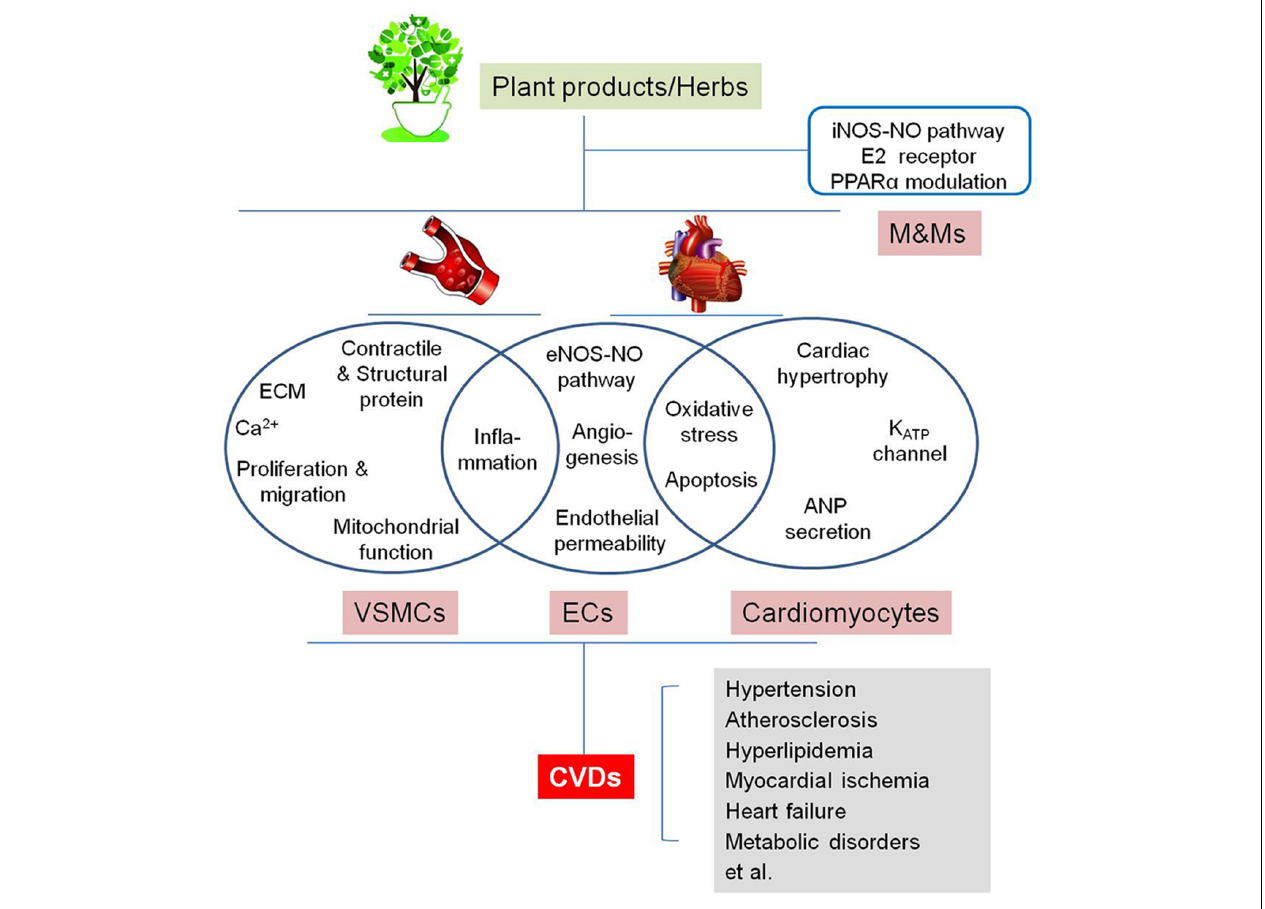
FIGURE 1 | A schematic diagraph indicating the targets on which plant products/herbs act during the pathogenesis of CVDs. Plant products/herbs demonstrate protective effect in CVDs by attenuating damage in cardiomyocytes, endothelial cells (ECs), vascular smooth muscle cells (VSMCs) and macrophages/monocytes (M&Ms). In VSMCs, plant products/herbs show the beneficial effect by inhibiting expression or activity of contractile and structural proteins, modulating expression of ECM proteins/glycoproteins, regulating calcium levels, attenuating proliferation and migrations, alleviating inflammation, and improving mitochondrial function. In ECs, plant products/herbs show the beneficial effect by inhibition of inflammation, oxidative stress and apoptosis, activation of endothelial nitric oxide synthase(NOS)-NO signaling pathway, induction of angiogenesis and suppression of endothelial permeability. In cardiomyocytes, plant products/herbs show the beneficial effect by inhibiting cardiac hypertrophy, oxidative stress and apoptosis, opening K ATP channels and increasing atrial natriuretic peptide (ANP) secretion. In macrophages and monocytes, plant products/herbs show the beneficial effect by inhibition of inducible NOS-NO signaling pathway, activation of estrogen receptor and nuclear receptor peroxisome proliferator activated receptor alpha (PPAR α ). A myriad of molecular, and cellular pathways are favorably modulated by plant products/plants or their